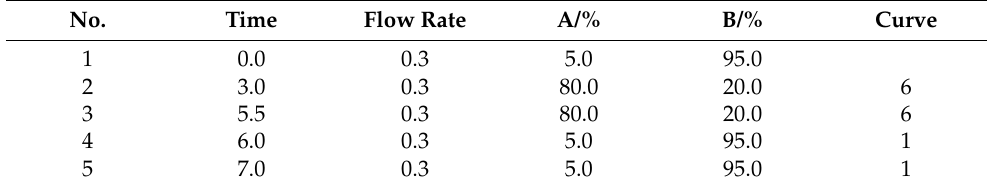
Table 2. Gradient elution procedure for UPLC.